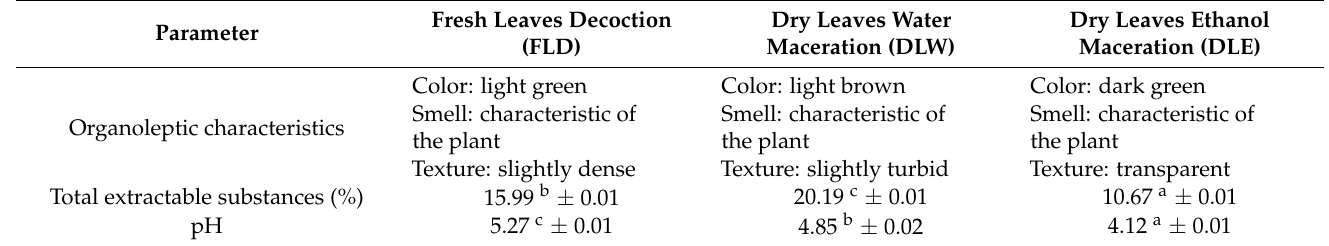
Table 2. Physical and physicochemical parameters of the extracts prepared from batch 2 (May 2018) of Plectranthus neochilus leaves grown in Santiago de